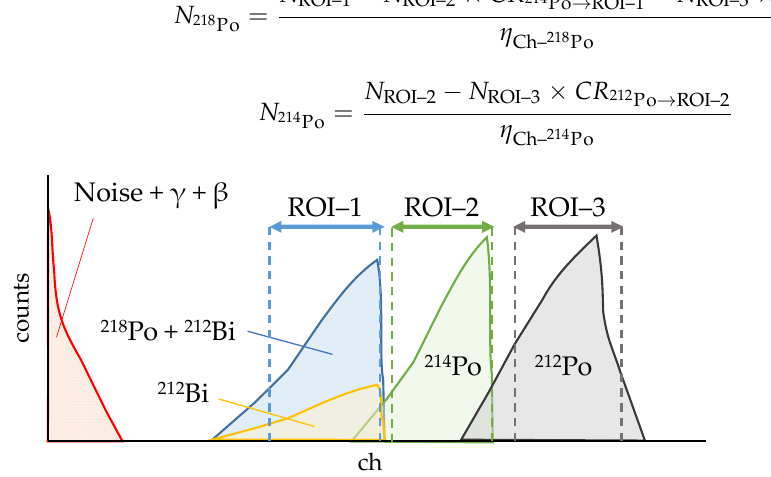
Figure 4. Schematic diagram of the observed alpha spectra.